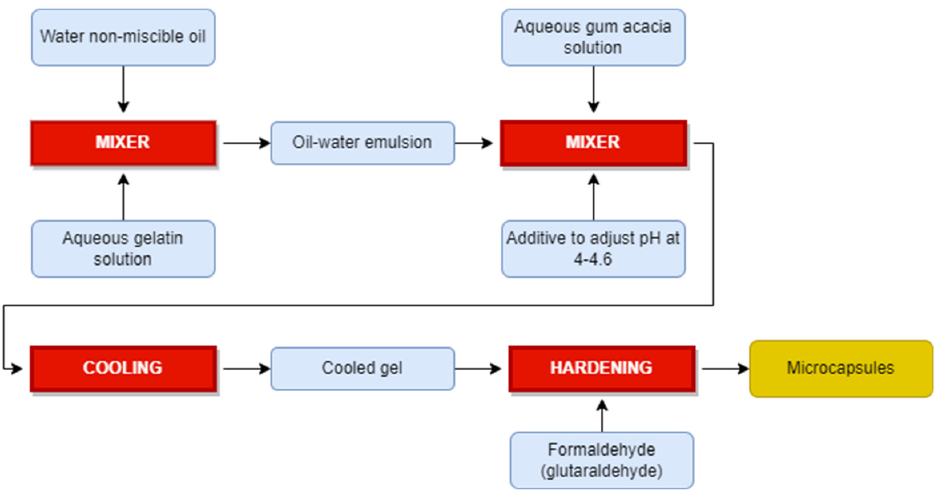
Figure 8. Microencapsulation method by coacervation process flow, Mishra [114]. The two microencapsulation processes result in micro particles of different size and dimensional distribution, as shown in Figure 9, Zhang et al. [115].